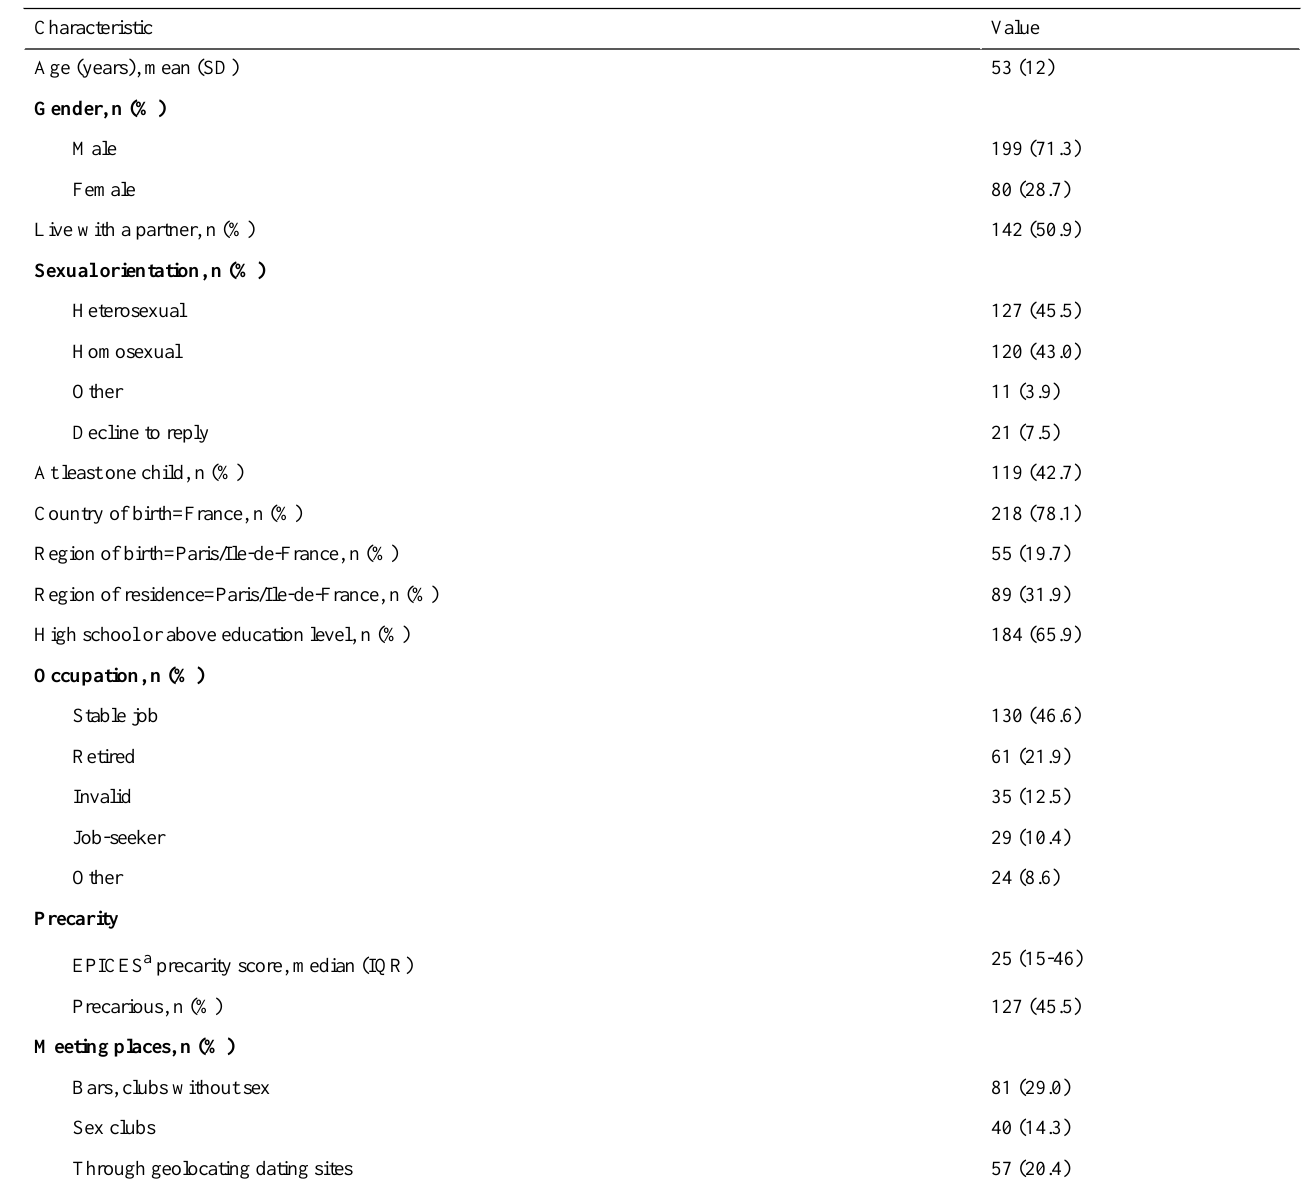
Table 1. Sociodemographic characteristics of people living with HIV